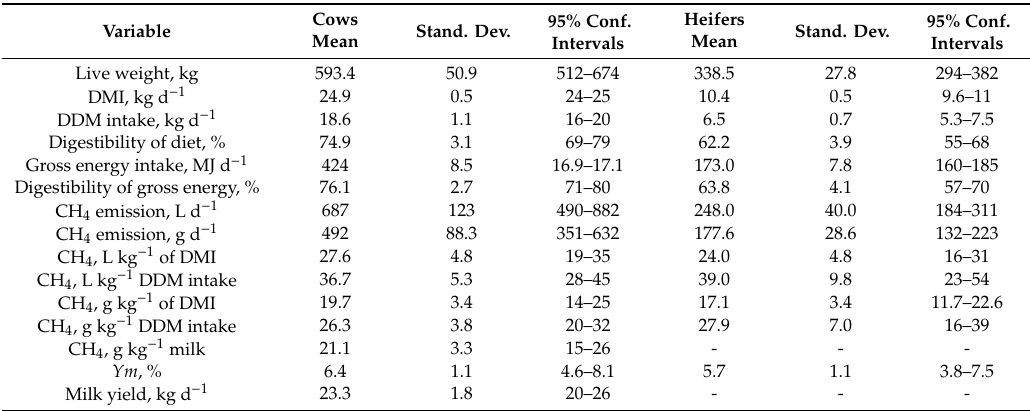
Table 3. Mean in vivo CH 4 production, dry matter and gross energy intakes, digestibility of dry matter and gross energy, methane conversion factor and methane yield for cows and heifers. Cows 95% Conf. Variable Stand. Dev. Stand. Dev. Intervals Live weight,